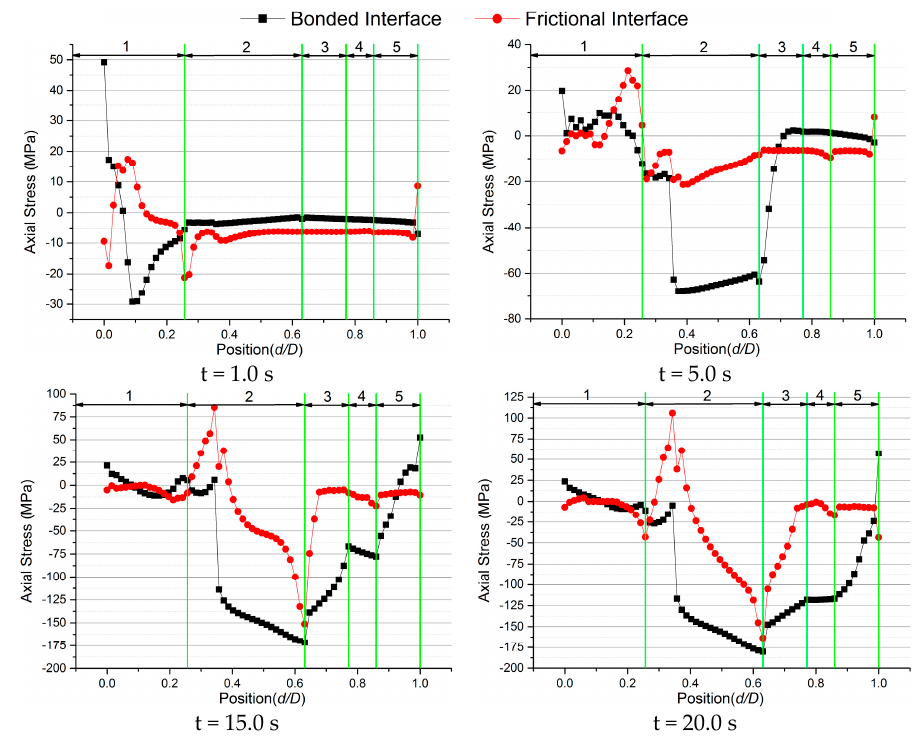
Figure 12. Axial stress variation curves of the passageway for the two different types of interface treatments. Energies 2016 , 9 , 430 14 of 20